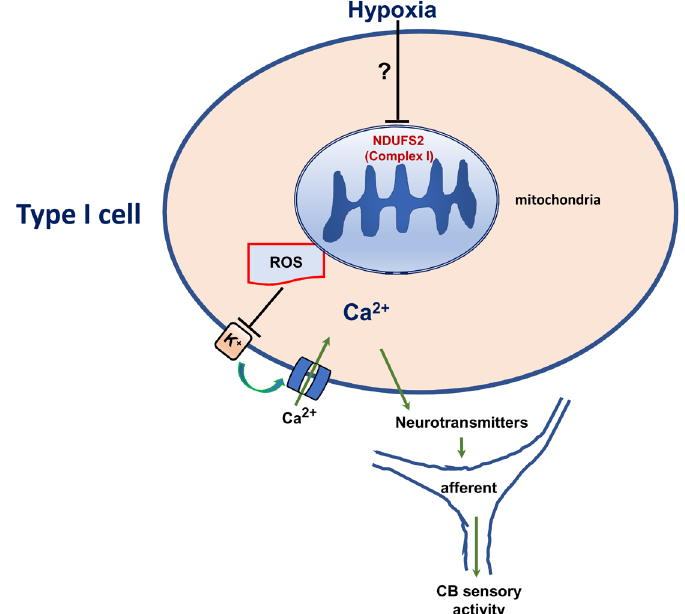
Figure 2. NADH dehydrogenase Fe-S protein 2 (NDUFS2), a mitochondrial complex I subunit, signaling in hypoxic sensing by the carotid body (CB). Ca 2+ , calcium channel; K + , potassium channel; ROS, reactive oxygen